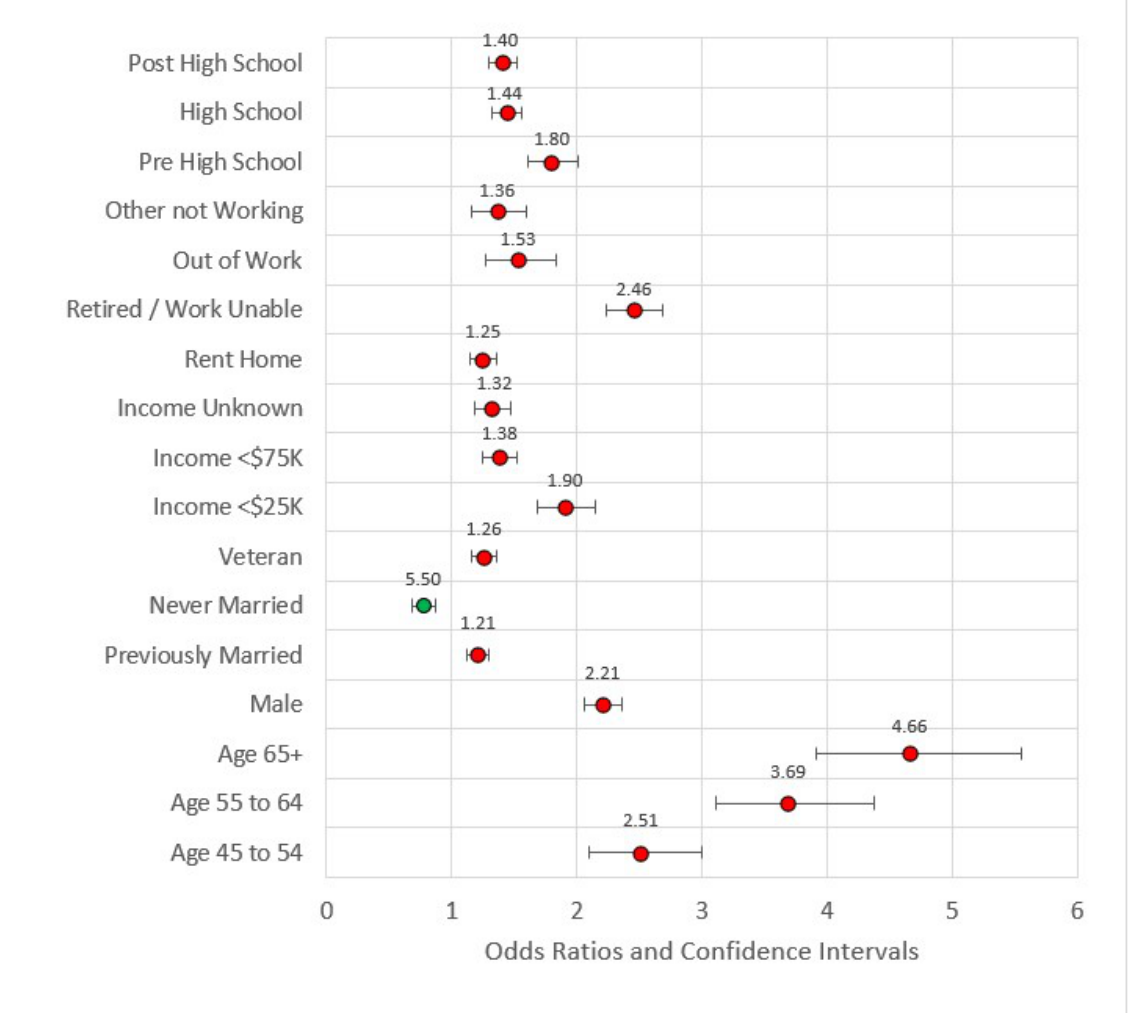
Figure 2. Forest plot of Model 2 (red = significant odds ratios greater than 1.0, green = significant odds ratios less than 1.0, black = not significant) .